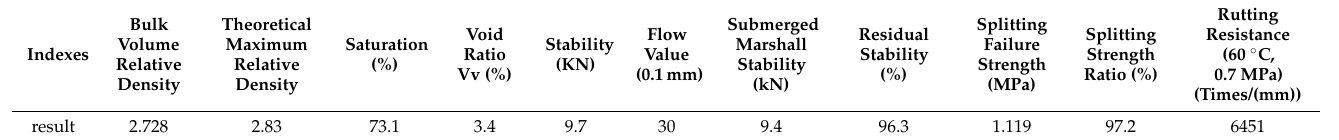
Table 5. Test indexes of active silicon AC-20 asphalt